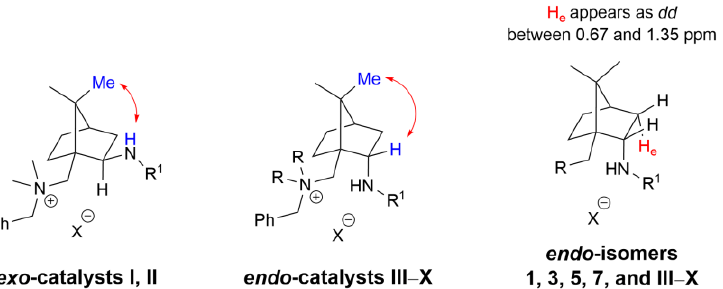
Figure 4. The determination of stereochemistry at the C-2 chiral center of compounds I – X by NOESY experiments and the correlation between the multiplicity of the H – C(3)- endo proton (H e ) and the endo absolute configuration at the C-2 chiral center of compounds 1 , 3 , 5 , 7 , and III – X ( Supplementary Materials).